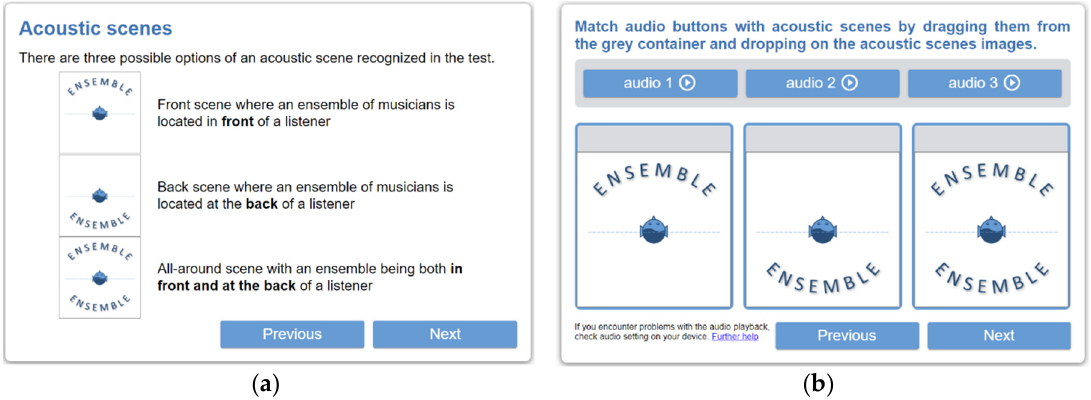
Figure 1. Graphical user interface exploited in the developed web application: ( a ) excerpt from the instructions for the listeners; ( b ) interface used for spatial audio scene classification.